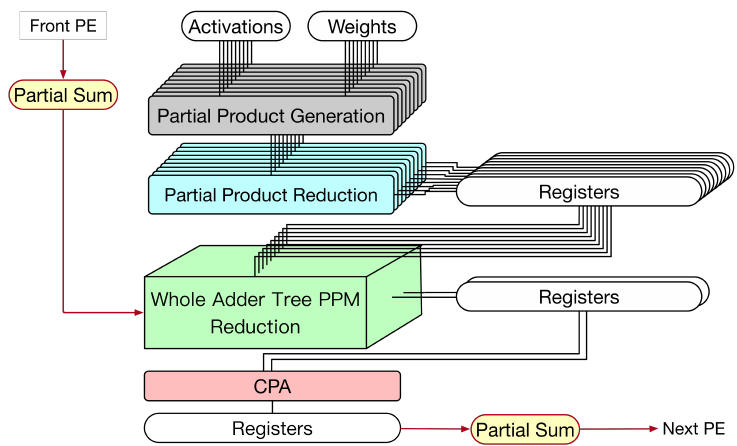
Figure 16. The proposed CA for weight stationary dataflow.